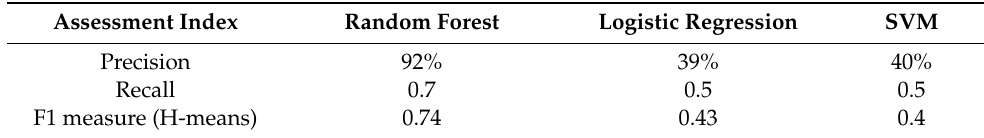
Table 4. Model evaluation indexes on the test dataset.